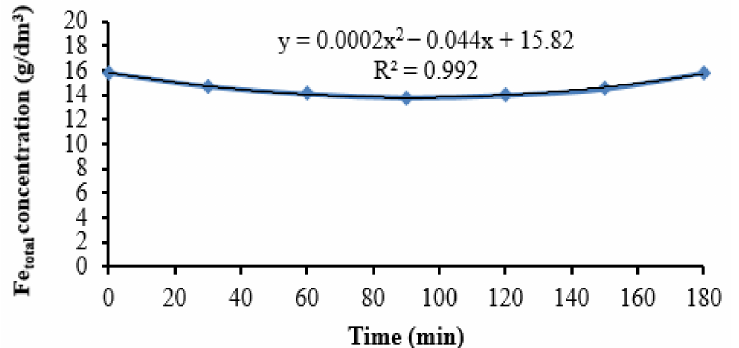
Figure 6. Change in the concentration of Fe total during electrooxidation in the flow cell. During the electrooxidation of iron in the flow cell, the content of sulfuric acid in the solution increases (Figure 7), which is associated with the occurrence of an electrochemical reaction of oxygen evolution at the anode as a result of water decomposition. The determi- nation of H 2 SO 4 was carried out by direct titration with a standard alkali solution. The pH at the equivalence point is 7. Methyl orange [33] was used as an indicator.